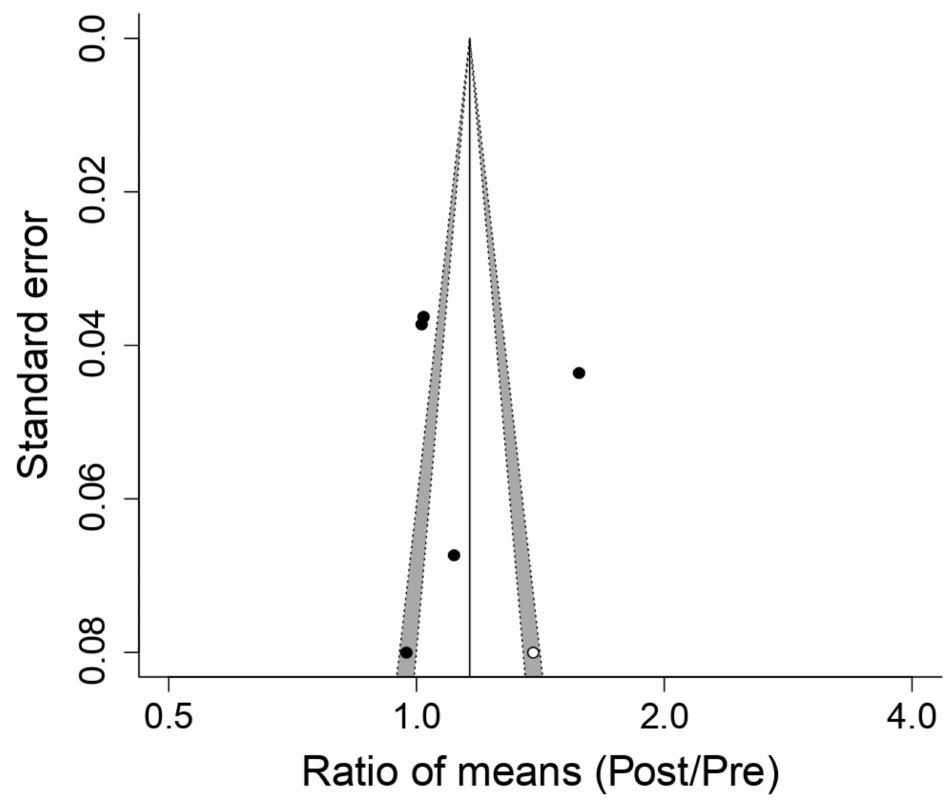
Figure 5. Funnel plot of the meta-analysis of the effects of inspiratory muscle training with PowerBreath ® on Maximal oxygen volume. Pre: Pre-inspiratory muscle training; Post: Post-inspiratory muscle